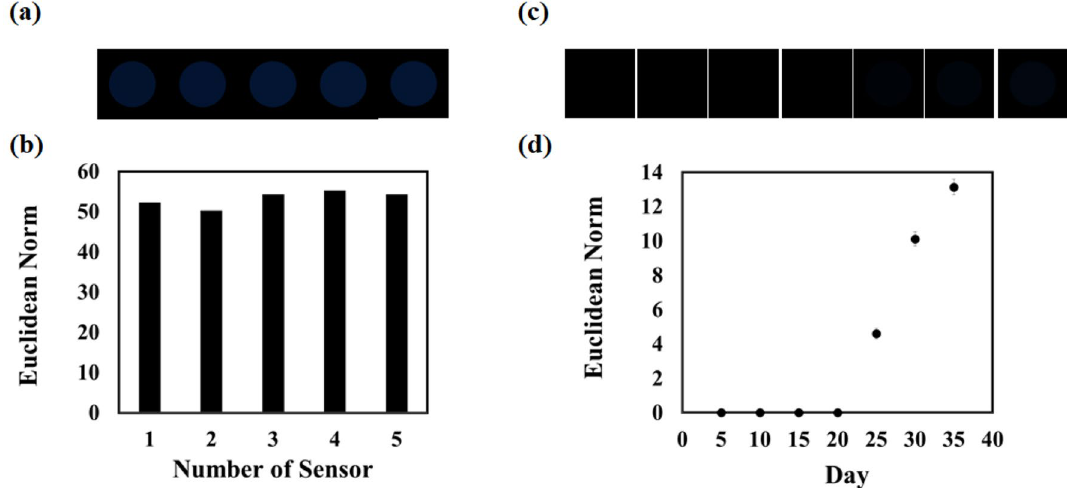
Figure 4. Evaluation of reproducibility of responses: ( a ) colorimetric difference maps and ( b ) numerical plot. Evaluation of the stability of fabricated µPAD: ( c ) colorimetric difference maps and ( d ) numerical plot. The study was performed in the presence of 2.0 µL of analyte (40.0 µmol L −1 ), TCA (25.0% W/V), borate